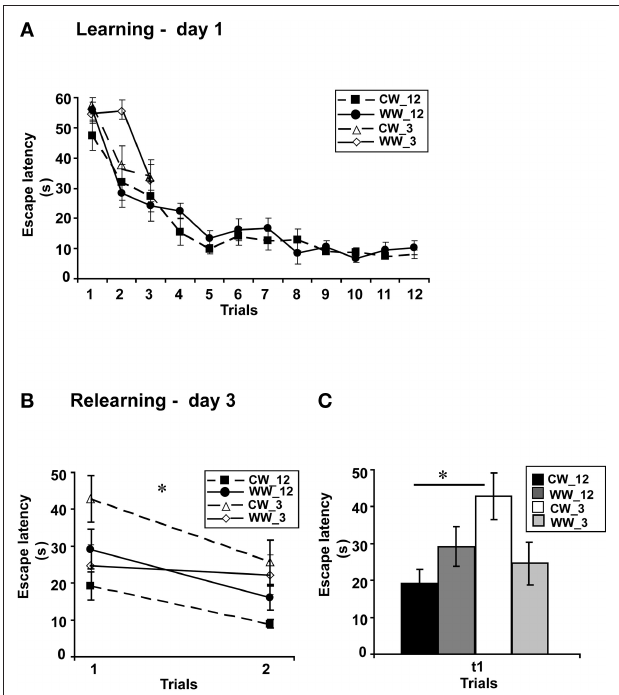
Figure 4 | Spatial memory formed in the Morris water maze using spaced training under different stress conditions. (A) Mean escape latencies for each of 12 initial training trials (day 1–3) did not differ between WW and CW animals; (B) However, memory retention as tested on day 5 (during relearning) was better in CW animals compared to WW animals; (C) The mean escape latency of the warm water animals during the first trail was significantly longer than that of the cold water animals (* p < 0.05). (CW, Cold Water; WW, Warm